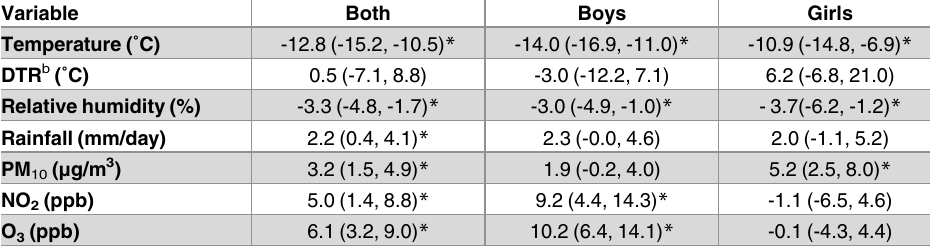
a Data are expressed as percent changes and 95% confidence intervals. Percent change indicates a change in AD symptoms according to an increase of 5-units in daily mean temperature, relative humidity, DTR, rainfall and an increase of 10-unit in PM 10 , NO 2 and O 3 ; b DTR: diurnal temperature range. All results were from the whole range of air